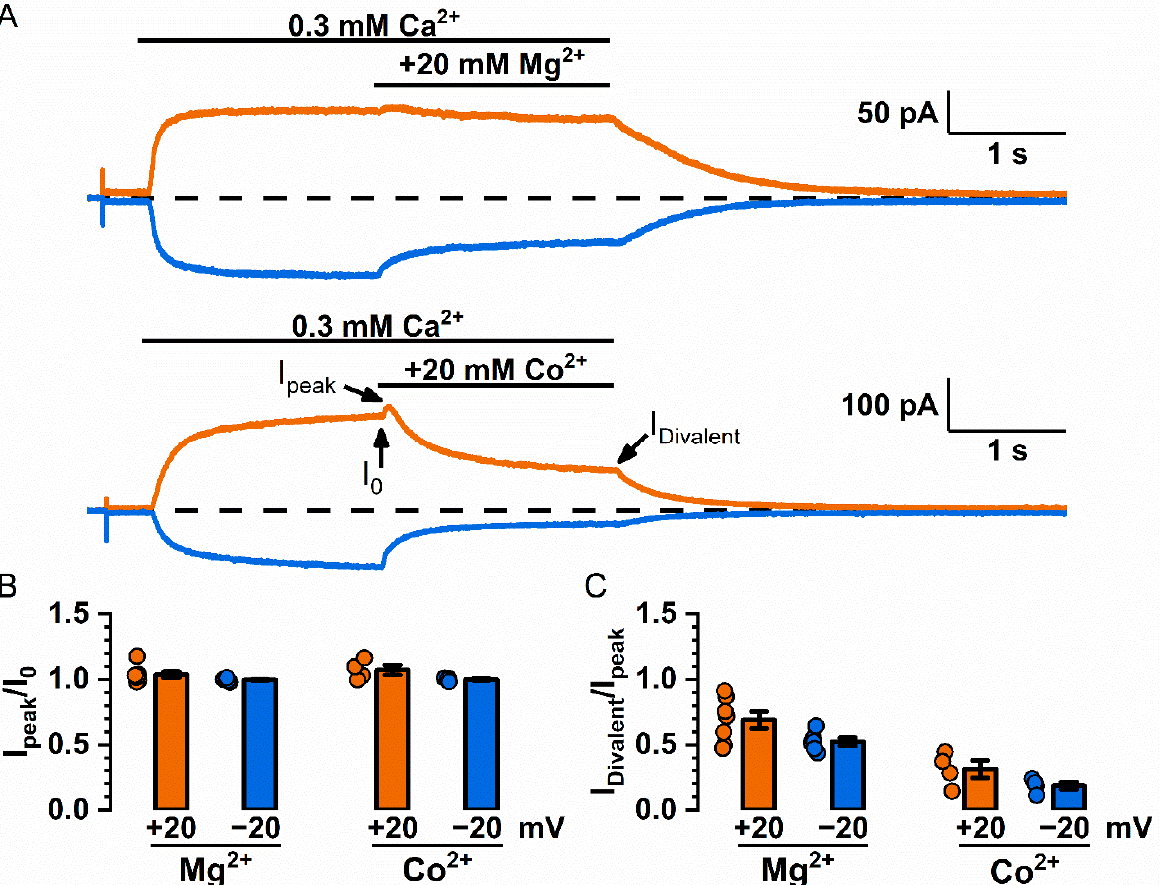
Figure 6. Potentiation and inhibition of the Q559W 16F current by Mg 2+ and Co 2+ . ( A ) Representative recording traces for the Mg 2+ and Co 2+ effects on the Q559W 16F current (induced by 0.3 mM [Ca 2+ ] i ). ( B ) Averaged potentiation (I peak /I 0 ) of Mg 2+ and Co 2+ on the Q559W 16F current. ( C ) Averaged inhibition (I Divalent /I peak , i.e., I Mg /I peak or I Co /I peak ) of Mg 2+ and Co 2+ on the Q559W 16F current.